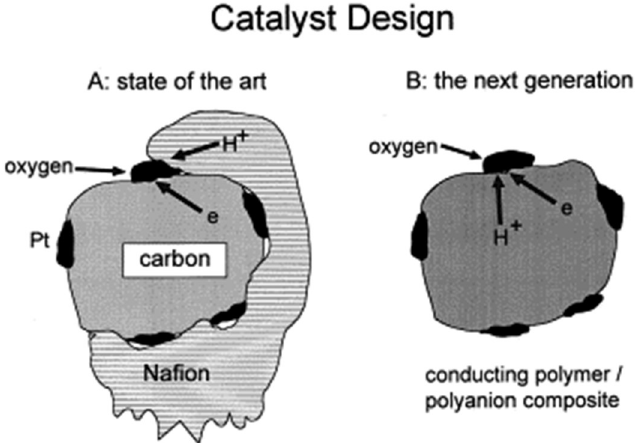
Figure 21. The commonly used electrode configuration ( A ) and the preferred design ( B ) in which the electronic conduction is added in parallel to the protonic one. Reprinted with permission from